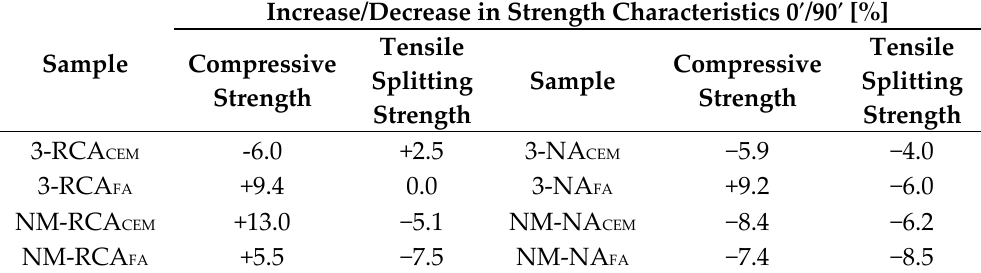
Table 2. Changes in strength characteristics of samples over the mixing time, grouped according to kind of